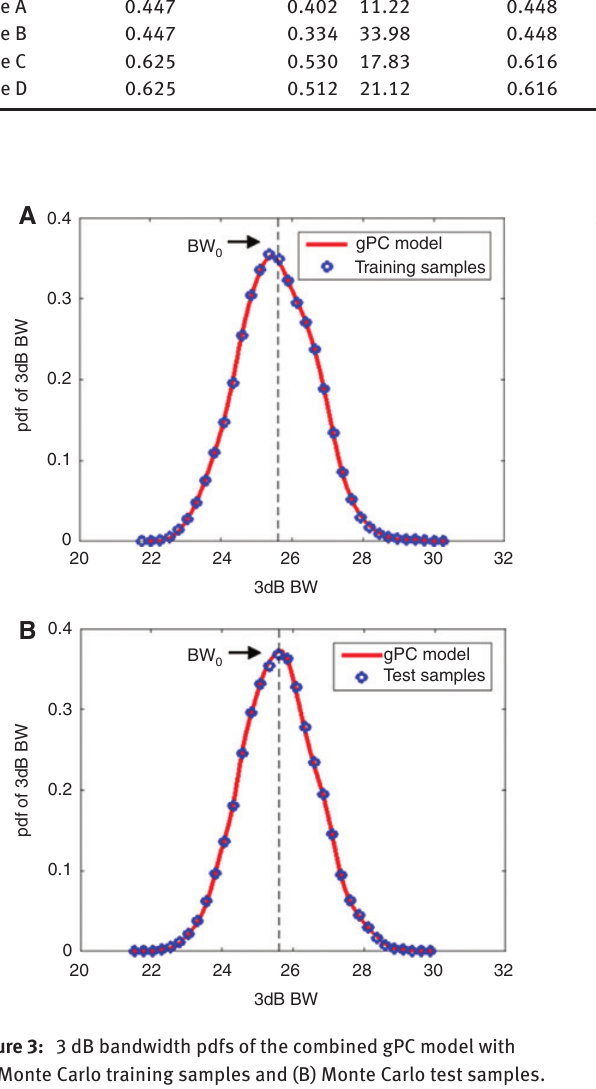
Figure 4: 3 dB bandwidth pdfs of Monte Carlo